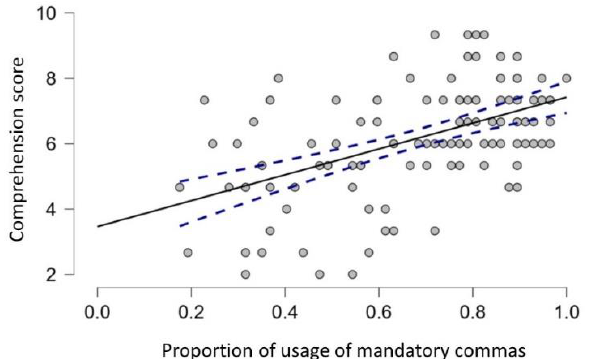
Figure 1. The proportion of use of the various types of commas in first-year students of secondary education, fourth-year students of secondary education, and first-year university students. For each condition, the bars represent the 95% confidence intervals.